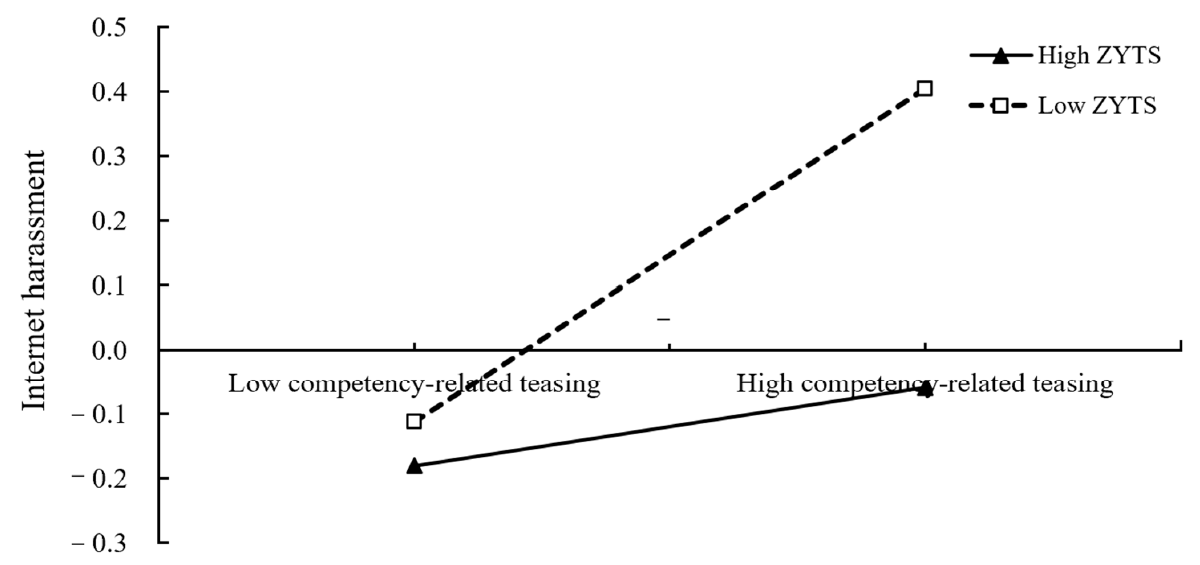
Figure 4. ZYTS as a moderator in the relationship between competency-related teasing and Internet harassment (ZYTS = the Zhong-Yong thinking style).